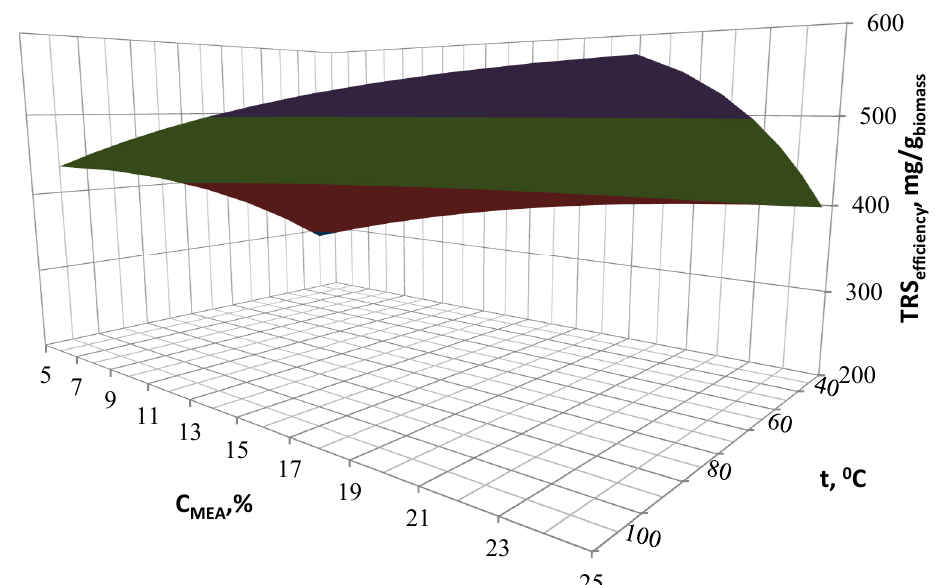
Figure 4. Influence of the pre-treatment time and temperature on the TRS efficiency.